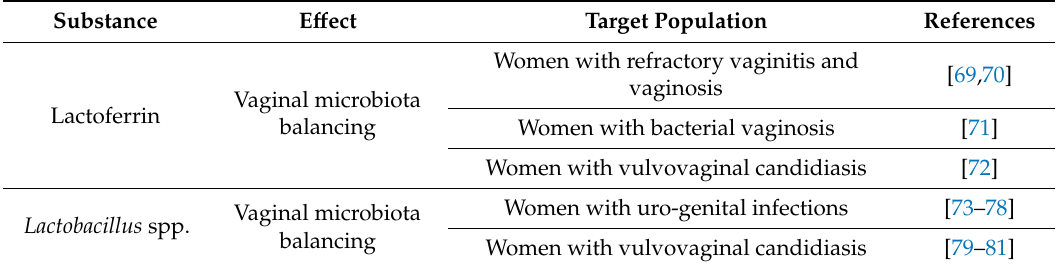
Table 3. E ff ects of lactoferrin or lactobacilli: Clinical